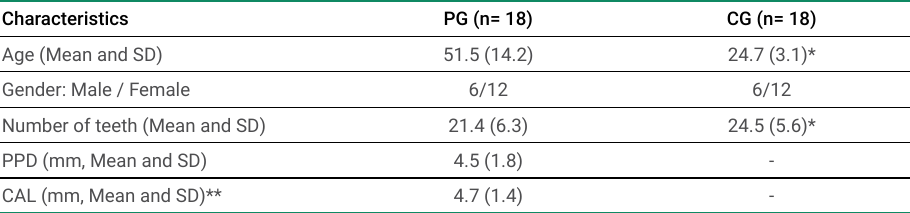
Table 2. Characteristics of studied individuals.